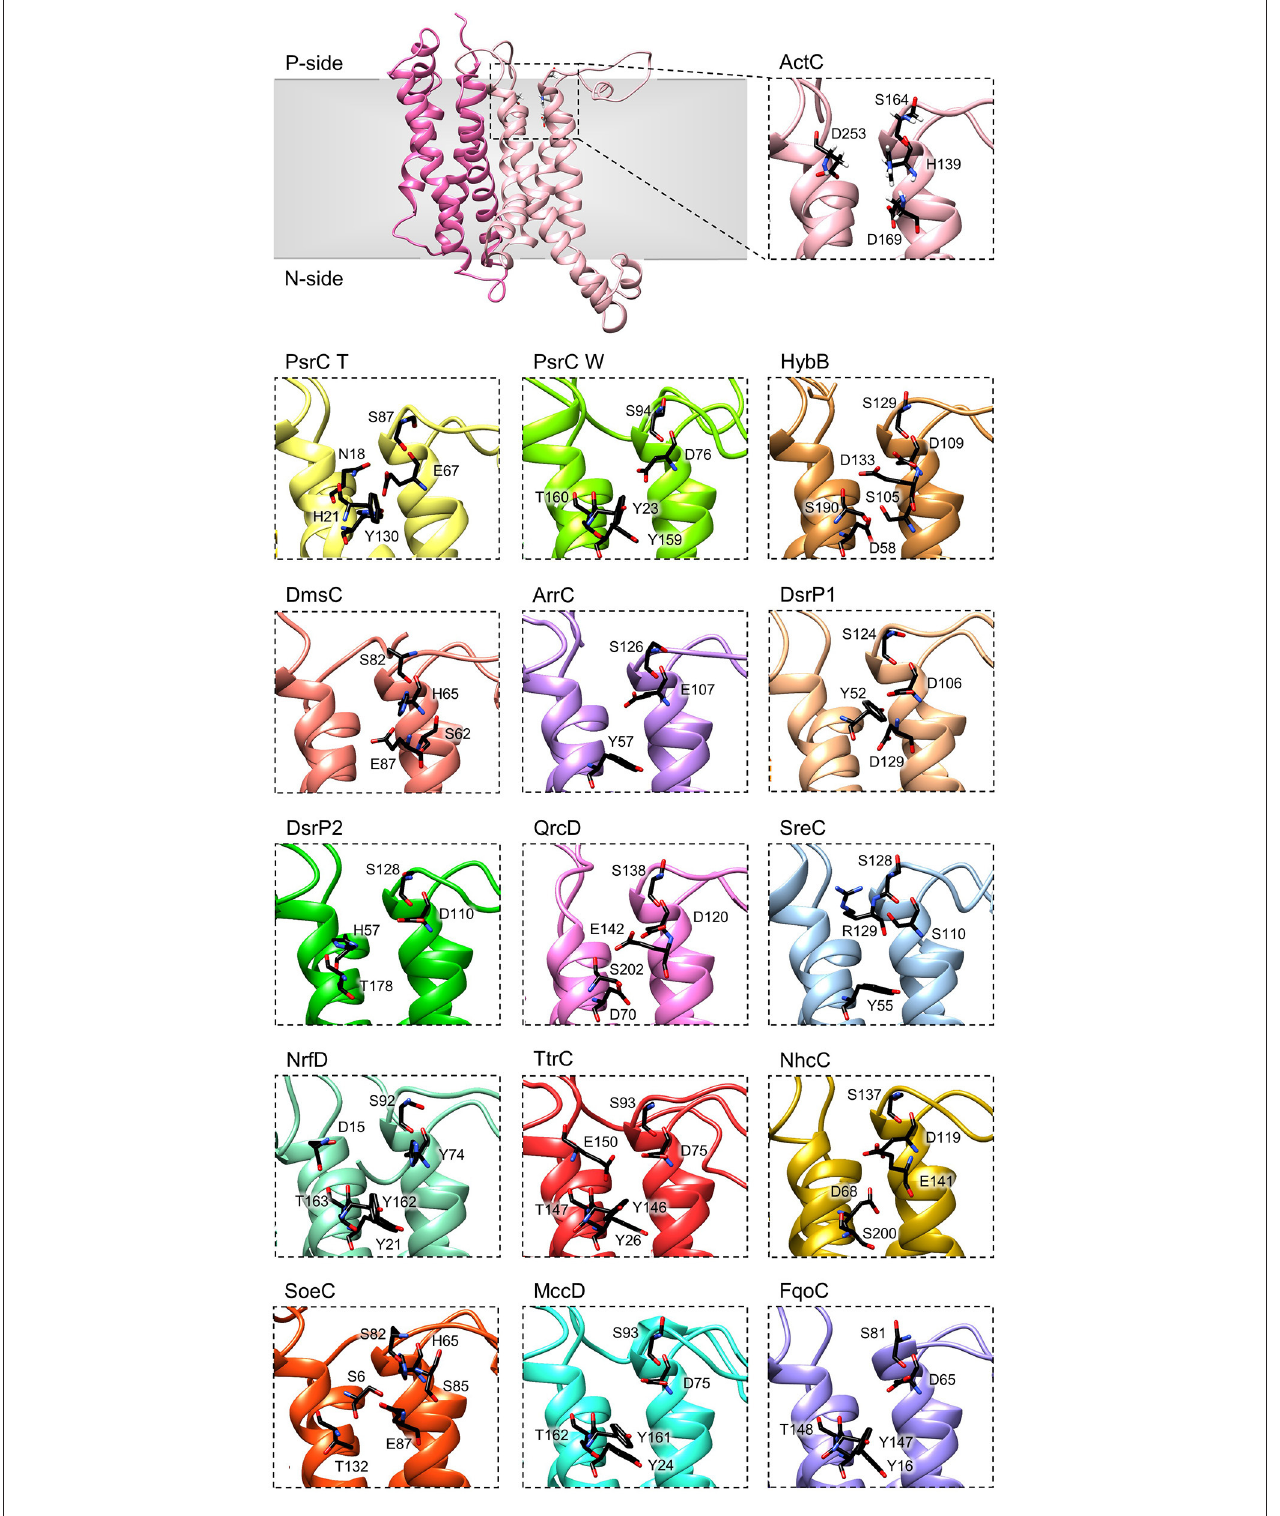
FIGURE 6 | Quinone-binding site. Zoomed views of structural models of NrfD-like subunits showing the respective putative quinone/quinol-binding sites, located close to the positive-side (P-side) of the membrane. The SoeC subunit is expected to be in an inverted orientation toward the membrane in relation to the other NrfD-like subunits and thus its quinone/quinol binding site is located close to the negative-side (N-side). The amino acid residues composing the different quinone/quinol-binding sites are indicated and depicted as sticks. Please note that all models are oriented with the P-side of the membrane at the top of each panel, except for SoeC that is oriented with the N-side of the membrane at the top of the respective panel.